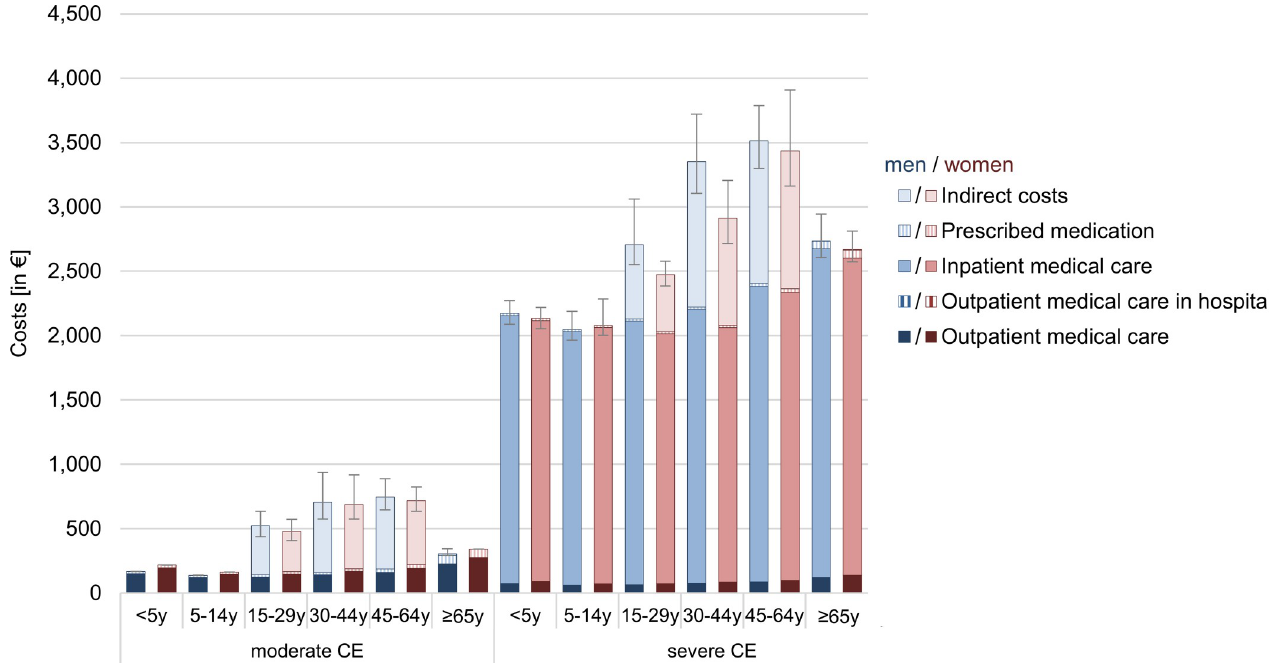
Fig 3. Mean costs of Campylobacter enteritis by age group and gender over a 12-month period. Costs per patient in € . Error bars indicate 95% confidence intervals of total costs. CE: Campylobacter enteritis, y: years.